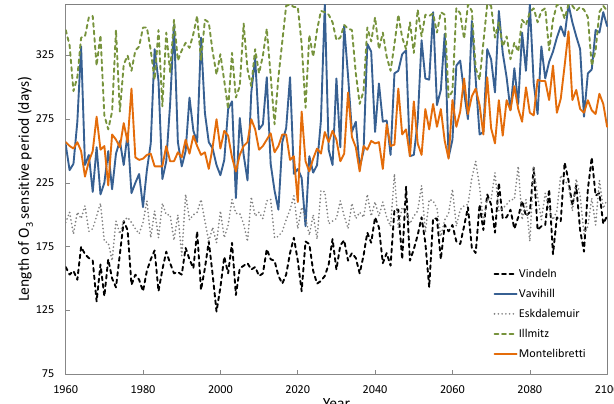
Figure 4. Calculated length of O 3 sensitive period (days), relevant for coniferous and evergreen tree species, during 1960–2100 at five sites in Europe. At Vindeln and Vavihill (Northern Europe) the start (end) of the period is defined as when the daily average tempera- ture exceeds (falls below) 5 ◦ C on 5 consecutive days. At Eskdale- muir (Atlantic Central Europe), Illmitz (Central Continental Eu- rope) and Montelibretti (Mediterranean Europe) the start (end) of the period is defined as the first (last) day that the daily summed stomatal conductance exceeds 30% of the theoretical maximum daily summed stomatal conductance. At Illmitz the stomatal con- ductance was calculated based on Continental Central European Norway spruce parametrisation, at Eskdalemuir the Atlantic Cen- tral European Scots pine parametrisation and at Montelibretti the Mediterranean Europe Holm oak